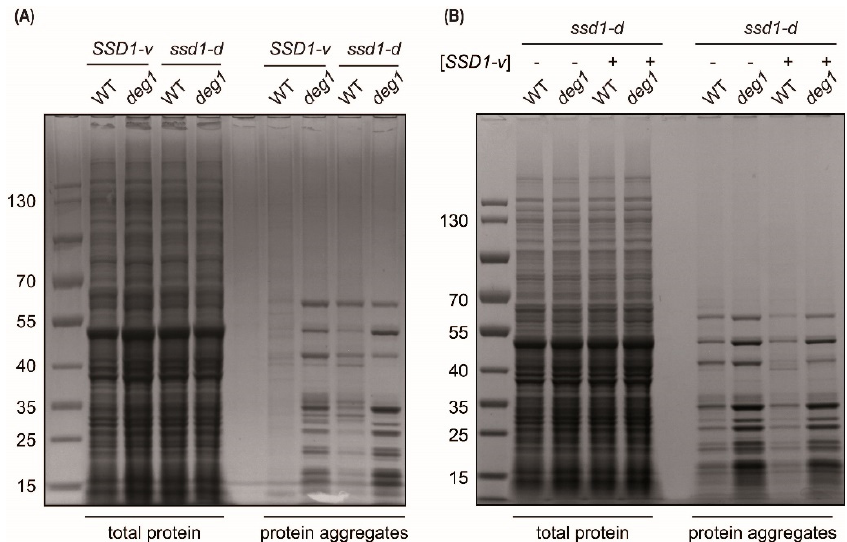
Figure 5. Impact of deg1 and ssd1-d on protein aggregation. Total protein and aggregate contents were extracted from ( A ) WT and deg1 mutants in both SSD1-v and ssd1-d backgrounds. ( B ) Total protein and aggregate contents from ssd1-d WT and the ssd1-d deg1 mutant in the presence (+) and absence ( − ) of plasmid-based SSD1-v [ SSD1-v ]. Samples were analyzed by Nu-PAGE and Coomassie staining.